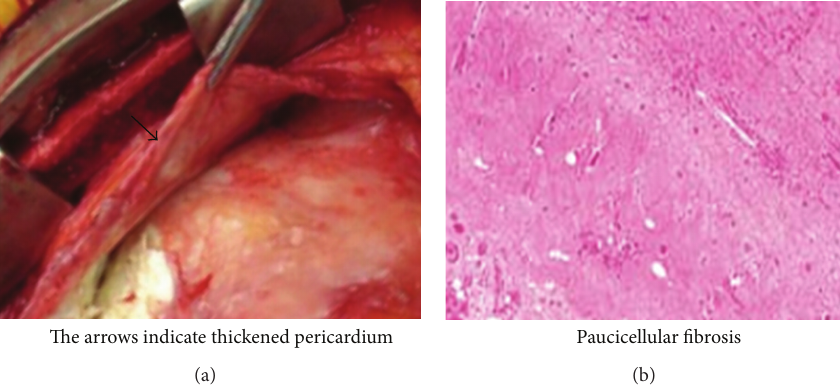
Figure 4: Surgical and pathological